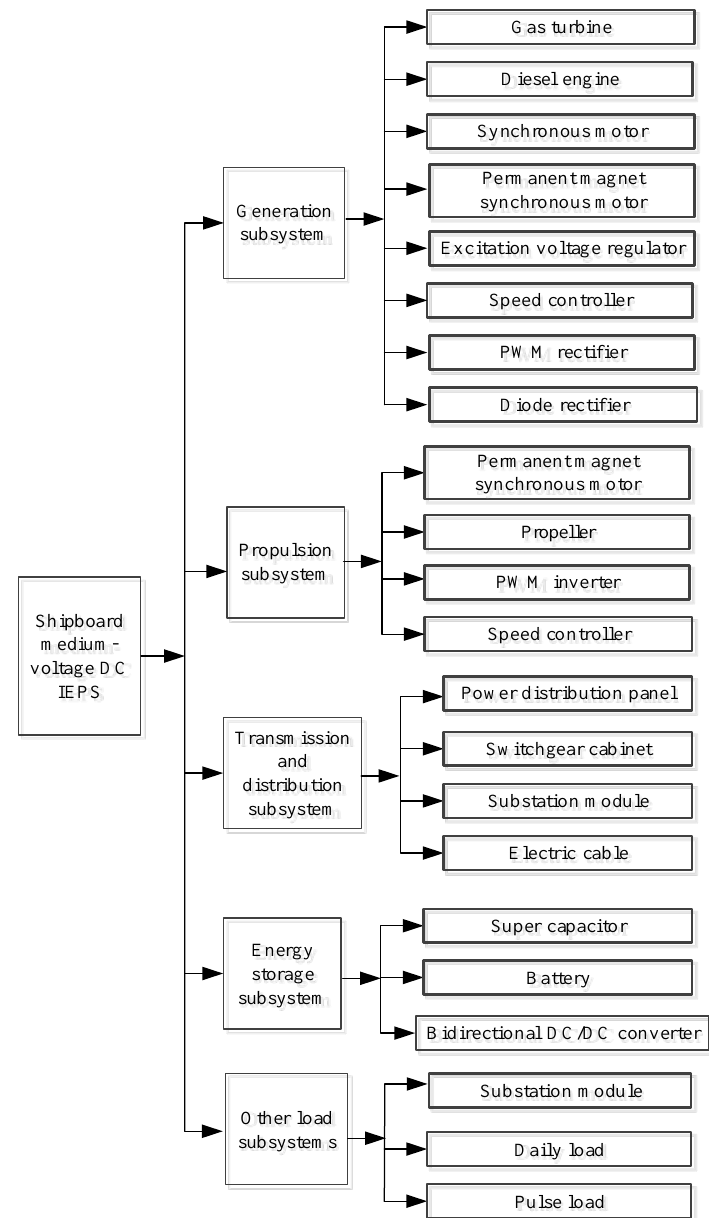
Figure 2. Hierarchical structure diagram of a shipboard IEPS. PWM represents pulse width